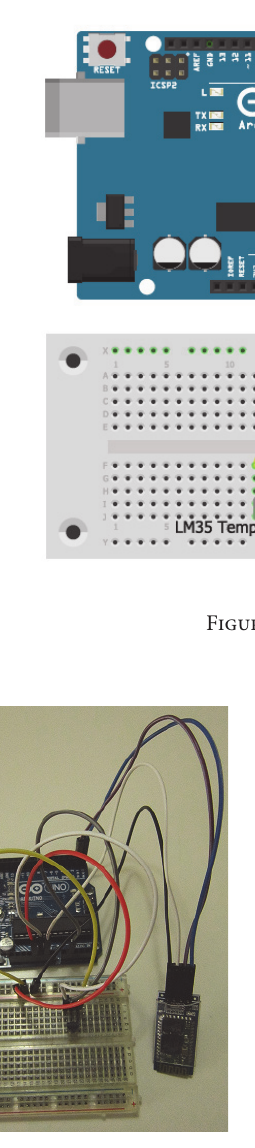
Figure 10: Real-time implementation of sensor configuration.